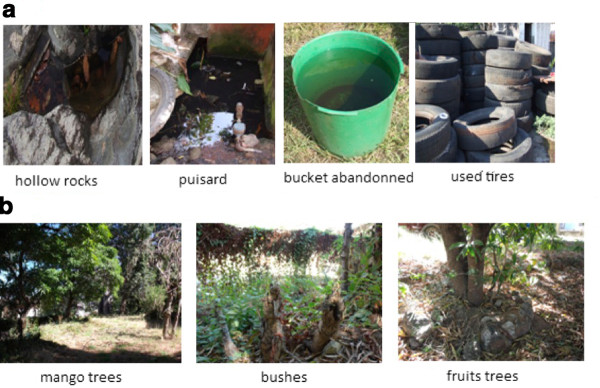
View of mosquito breeding sites. A: sites of immature stages; B: sites of adults.